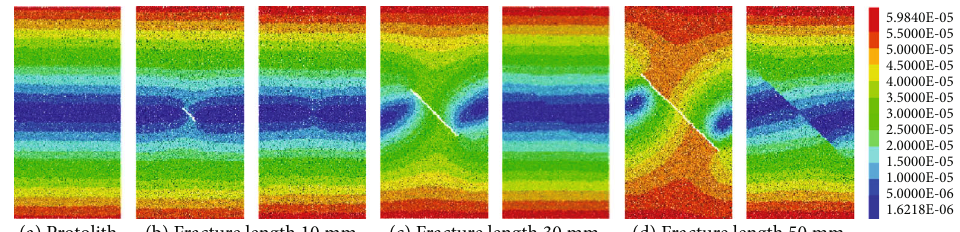
Figure 5: Displacement change in limestones with di ff erent prefabricated crack lengths.